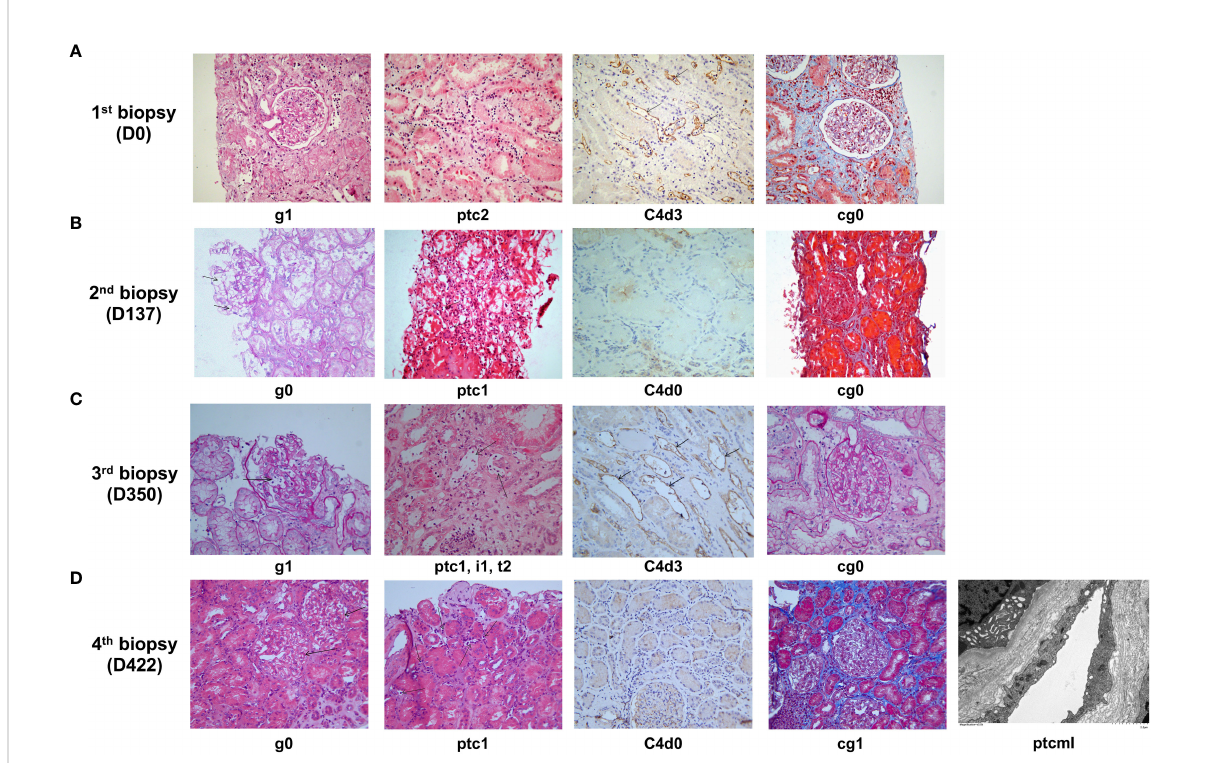
FIGURE 3 Histological features of late active AMR in Patient 2 before and after treatment. (A) Typical histological fi ndings of active AMR in Patient 2 before the treatment and their Banff 2019 Scores. (B) The pathology results of a second renal biopsy performed on day 137 after the initiation of treatment and their Banff 2019 Scores. (C) The pathology results of a third renal biopsy performed on day 350 after the initiation of treatment (when acute rejection was clinically suspected) and their Banff 2019 Scores. (D) The pathology results of a fourth renal biopsy performed on day 422 after the initiation of treatment (when poor response was observed to daratumumab intensive therapy) and their Banff 2019